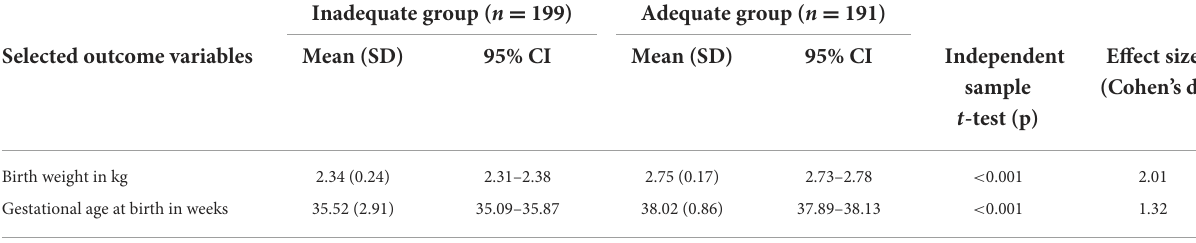
TABLE 5 The mean birth weight and preterm birth of the study participants in the east Gojjam zone by their dietary diversity score status, east Gojjam zone, northwest Ethiopia, 2019/2020.